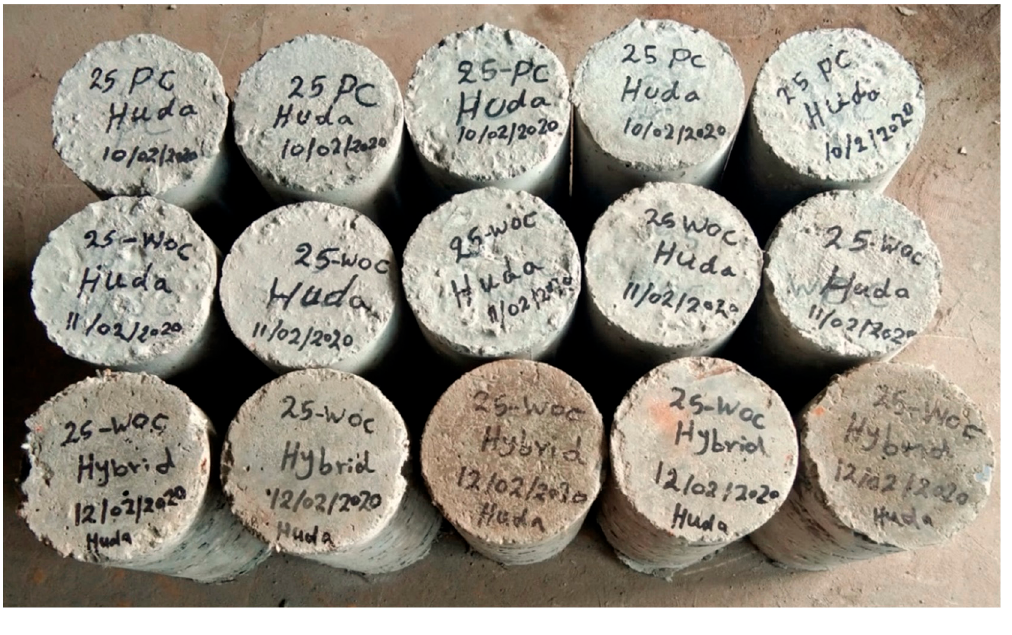
Figure 6. Prepare specimens for test. Table 4. Description of group testing of total 21 test specimens.